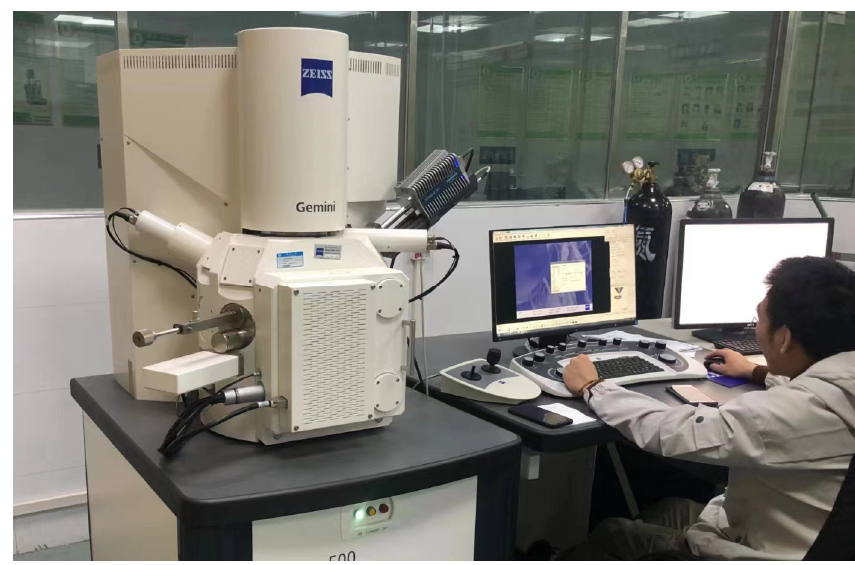
Figure 3. SEM test instrument.